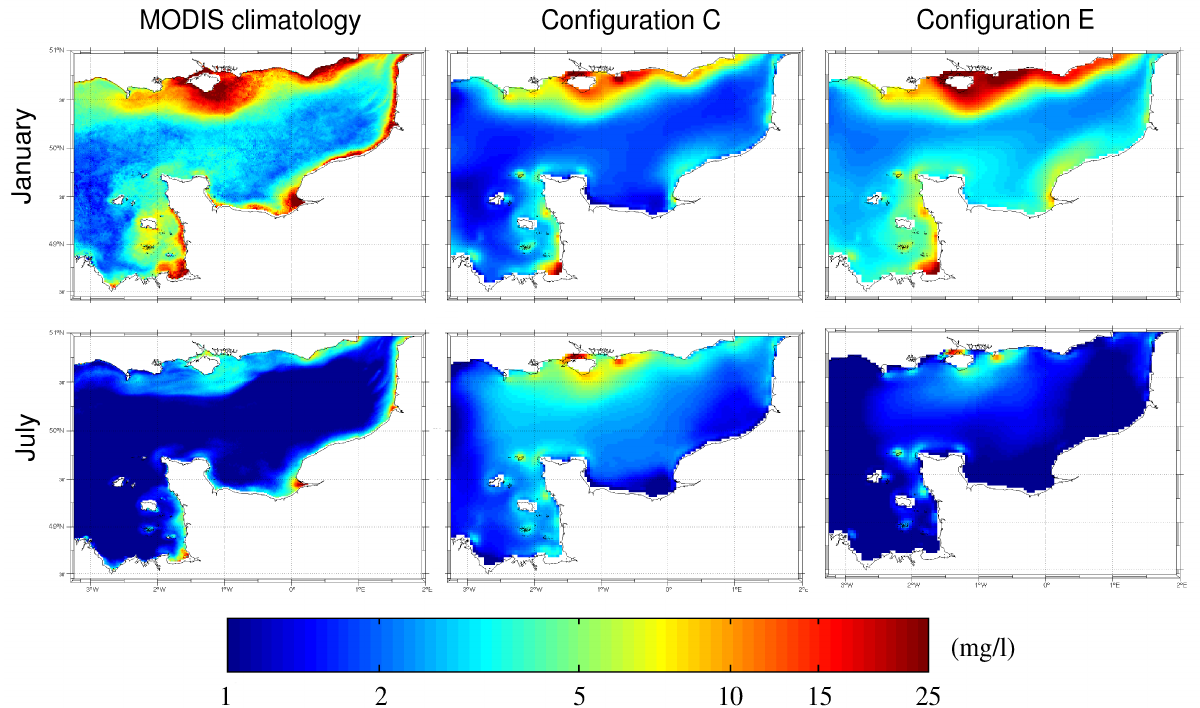
Figure 12. Monthly averaged near-surface SSC (left) issued from MODIS climatology and predicted in Configurations (center) C and (right) E in January and July,